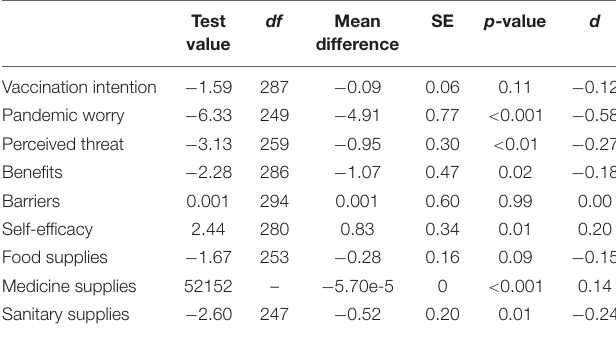
TABLE 2 | Group differences between participants without chronic illness and with chronic